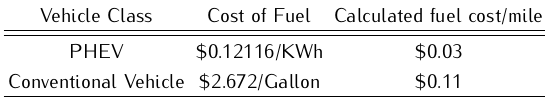
P PV and SOC, which will be used for deciding the control signals. P PV is the magnitude of the power flowing out of PV array and SOC is the state of charge of the battery pack which resides inside the